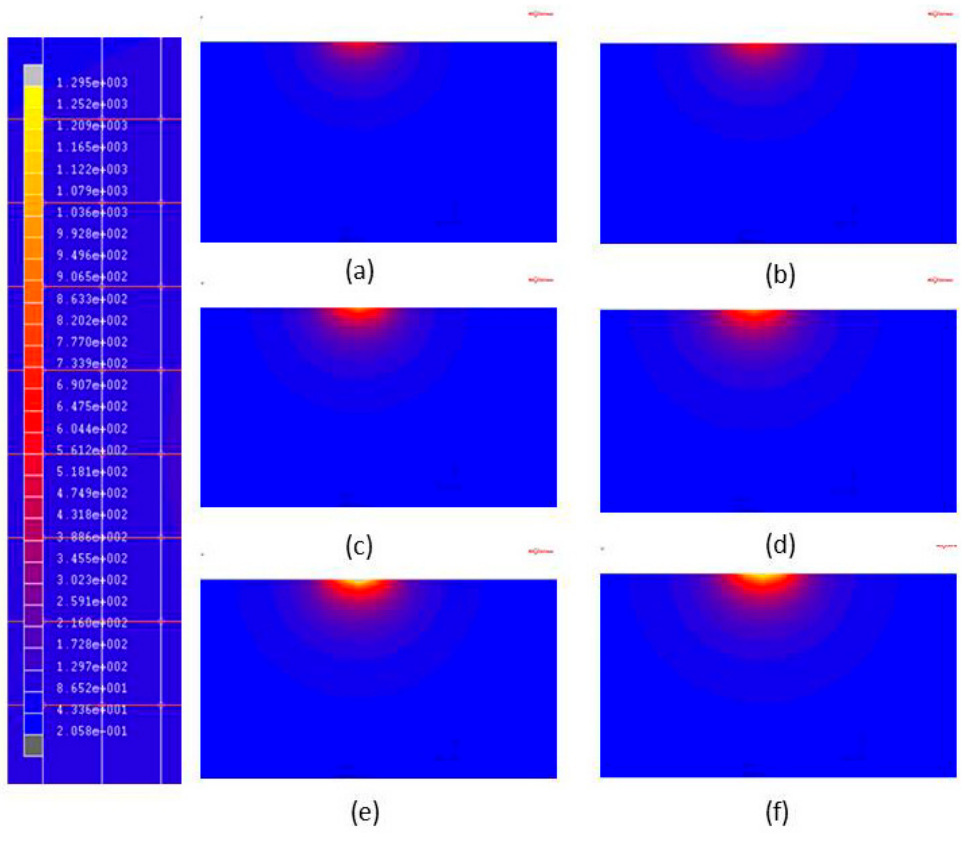
Figure 10. Temperature distribution profiles induced by different laser powers during single-track laser heat treatment. ( a ) AISI 1045, V i = 8 mm/s, P i = 250 W; ( b ) AISI 4140, V i = 8 mm/s, P i = 250 W; ( c ) AISI 1045, V i = 8 mm/s, P i = 350 W; ( d ) AISI 4140, V i = 8 mm/s, P i = 350 W; ( e ) AISI 1045, V i = 8 mm/s, P i = 450 W; and ( f ) AISI 4140, V i = 8 mm/s, P i = 450 W.